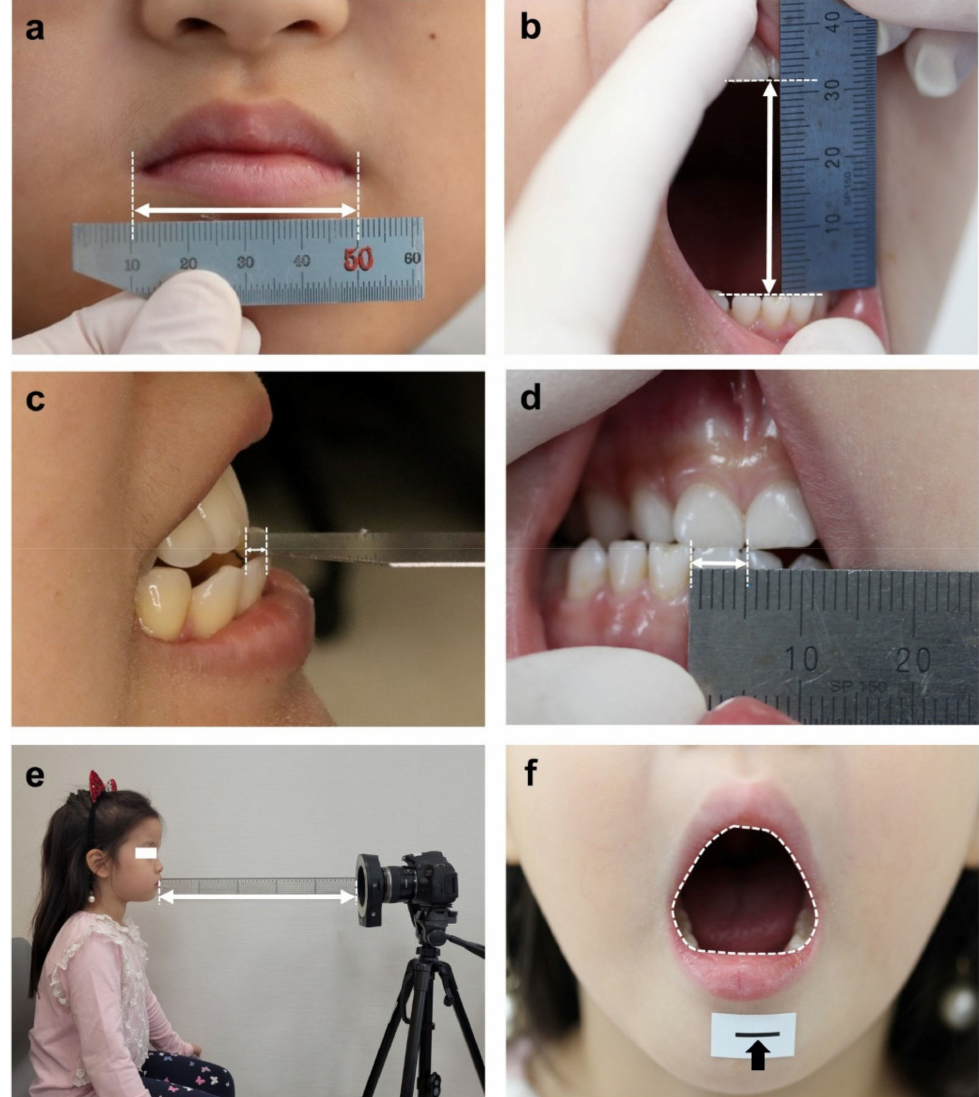
Figure 2. Measurement of mouth width ( a ), maximum mouth opening ( b ), protrusion ( c ), right laterotrusion ( d ), photo room setting ( e ), and mouth area ( f ). Mouth area was measured at the same location with a background indicating a distance of 50 cm. The measurement of mouth area was recorded in the inner area when the outline of the inner lip line was connected, and calculated by placing a sticker that sets the standard of 10 mm (black